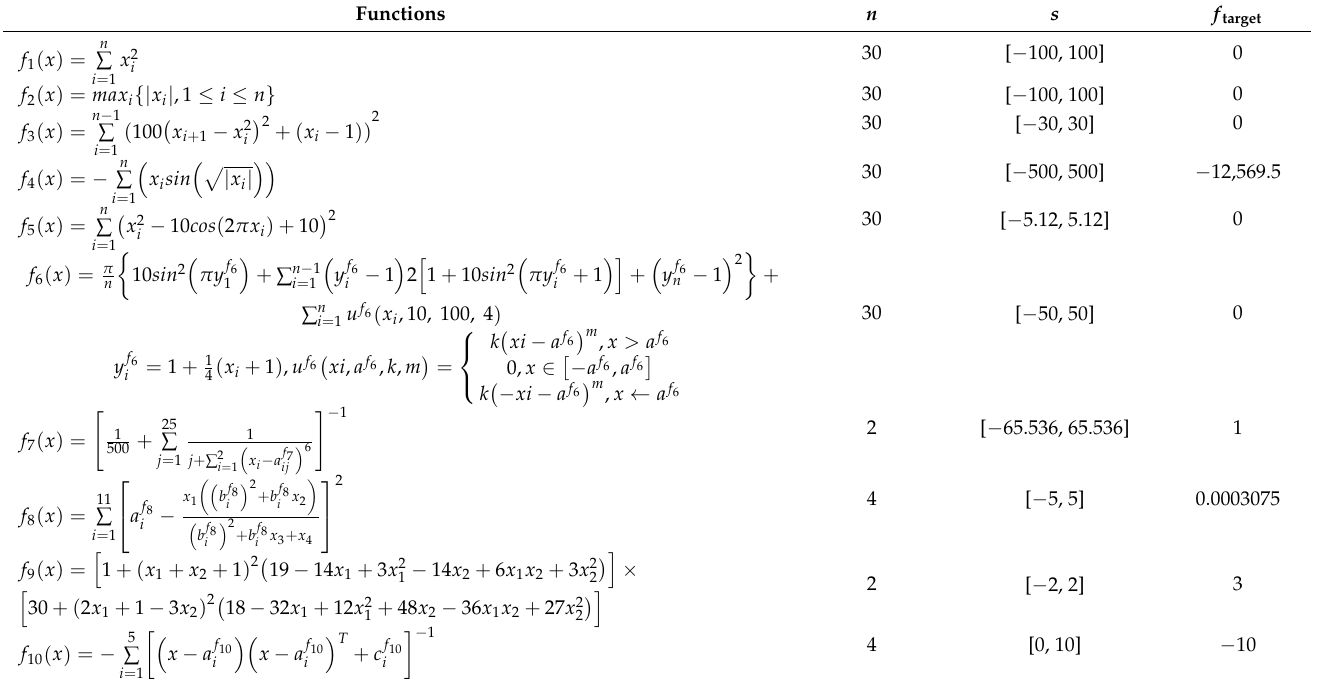
Table 11. Benchmark functions used in this study.